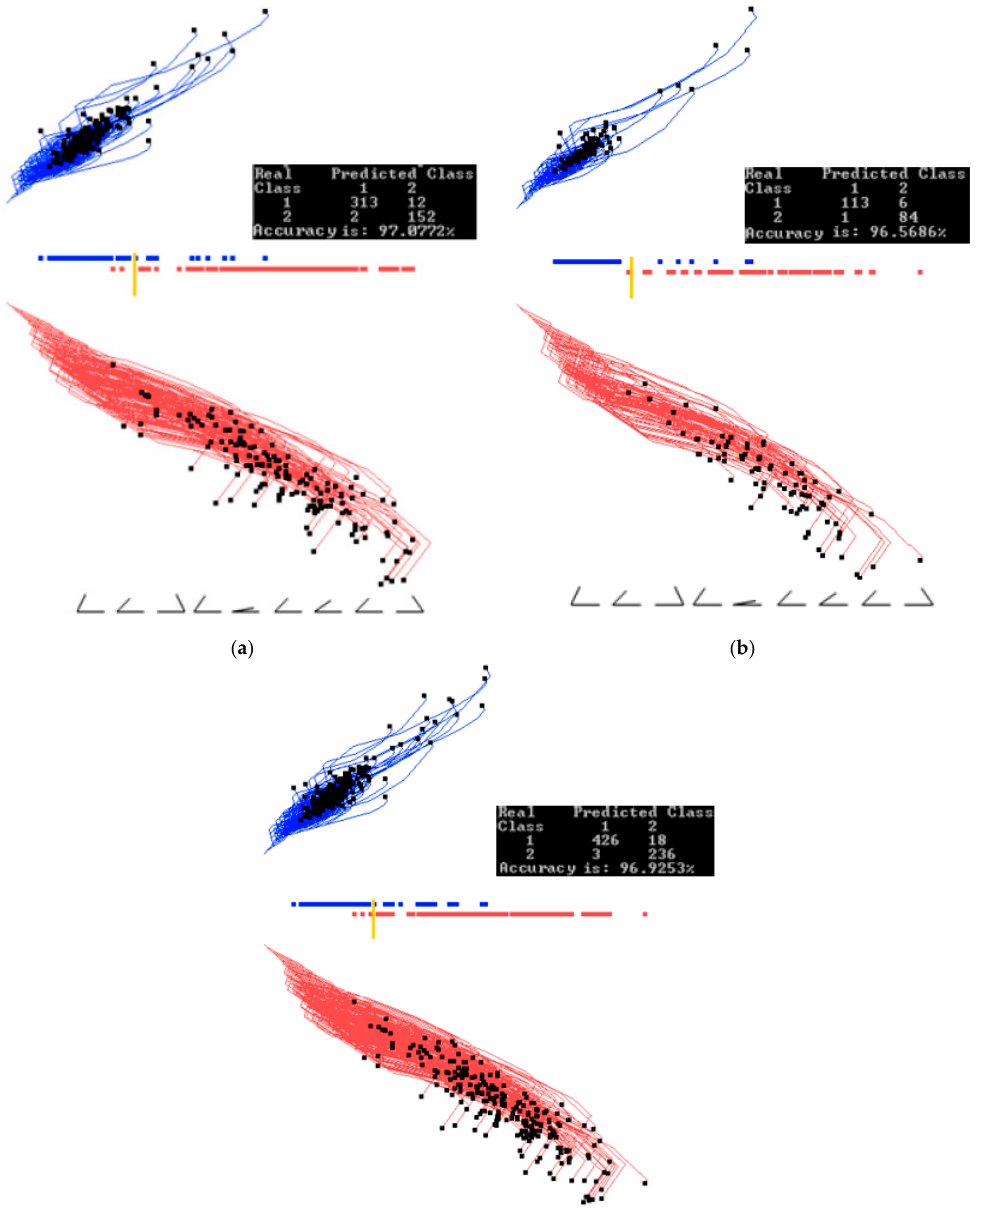
Figure 7. Results for the Wisconsin breast cancer data showing the training, validation, and the entire data set when trained on the training set. ( a ) Data are split using 70% (training set) to the find coefficients with the projecting training set. Best result from the first runs of GLC-AL; ( b ) Using the coefficients found by the training set in ( a ) and projecting the validation data set (30% of the data); ( c ) Projecting the entire data set using the coefficients found by the training set in ( a ).